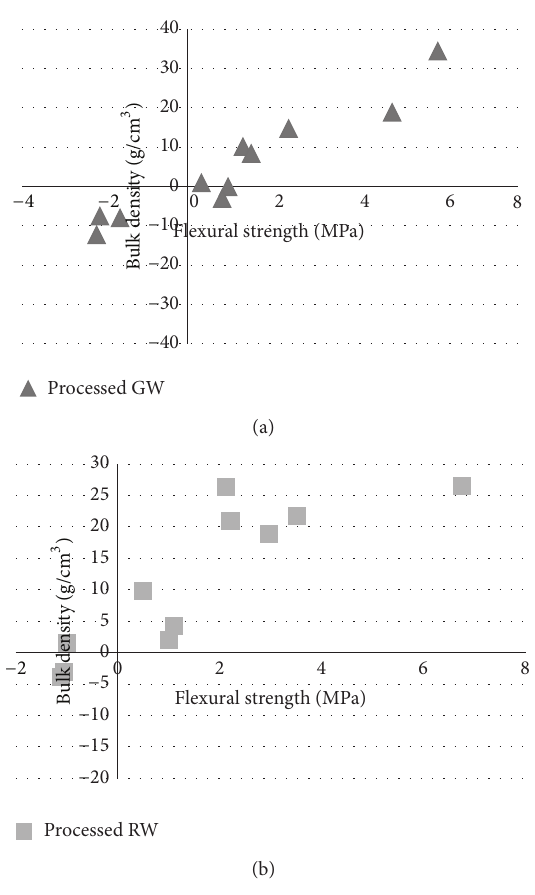
Figure 9: Flexural strength comparison between the series and the reference sample.